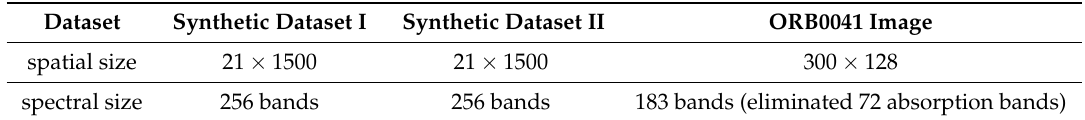
Table 2. Characteristics of the datasets.